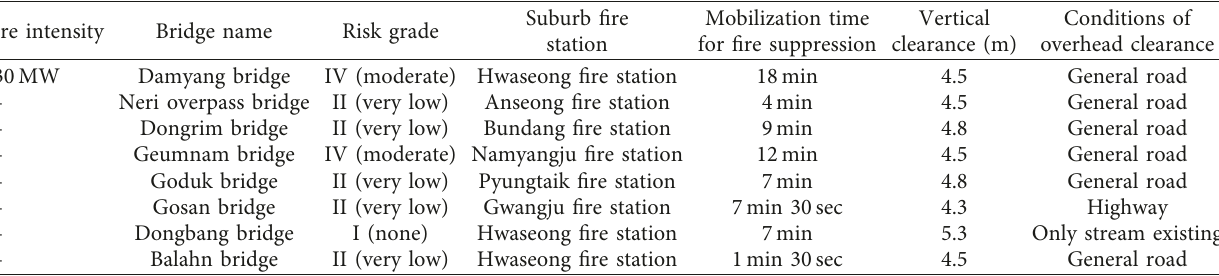
Table 12: Risk grade on steel bridge with 130MW